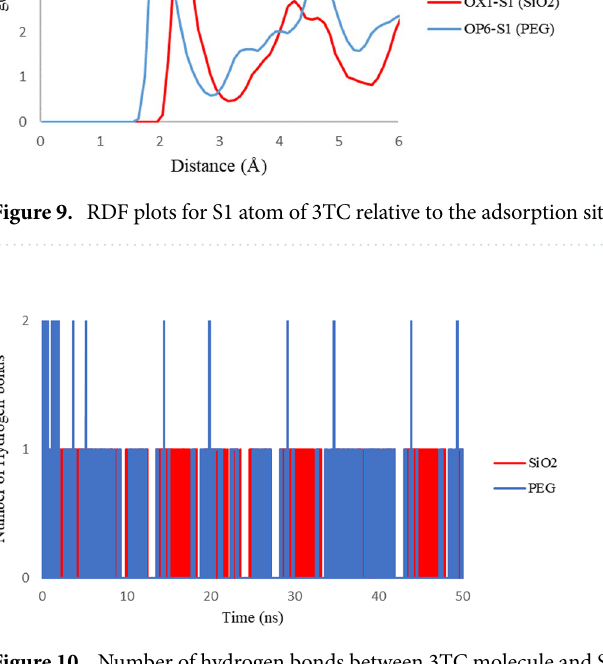
Figure 10. Number of hydrogen bonds between 3TC molecule and SiO 2 (red) and PEG (blue) during the simulation